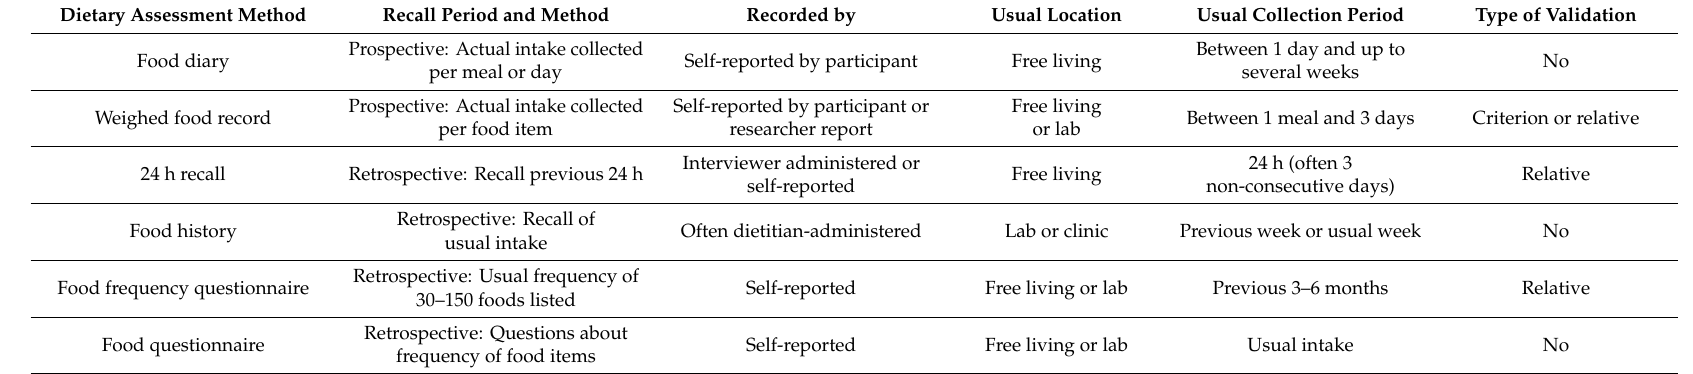
Table 1. Characteristics and defining features used for categorisation of dietary assessment